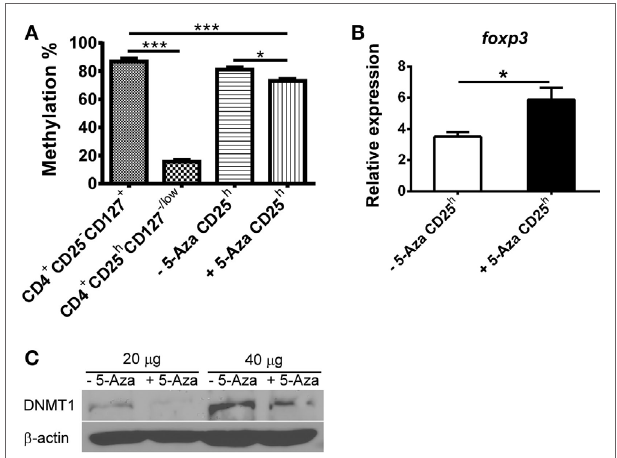
FigUre 3 | Treg-specific demethylating region in 5-aza-treated cD4 + cD25 h T cells is partially demethylated in company with higher foxp3 expression due to decreased DnMT1 . (a) CD4 + CD25 h T cells were sorted from 5-Aza-treated and -untreated cells. Other